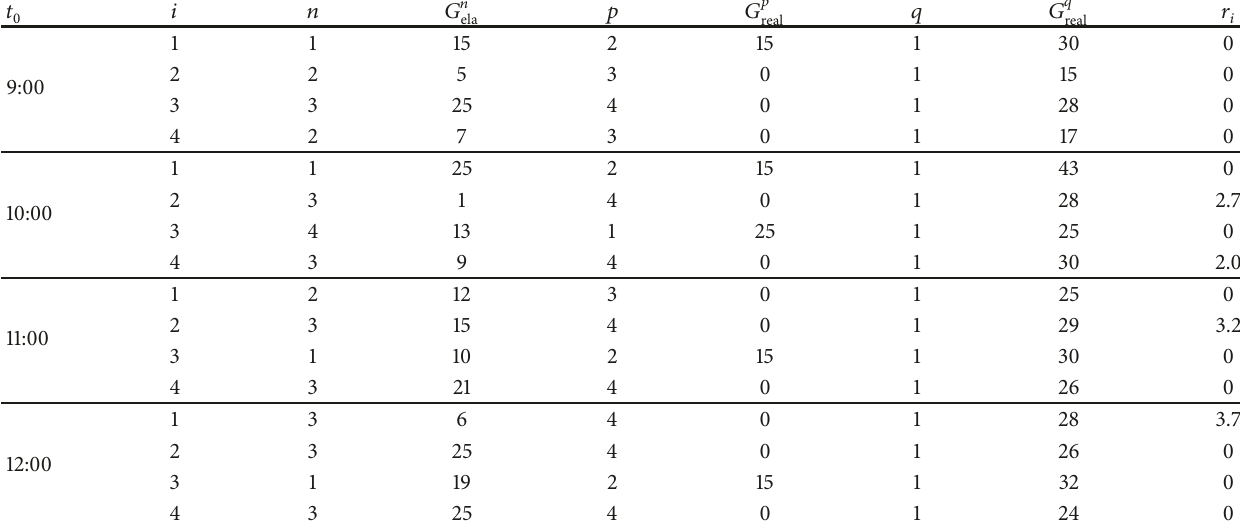
Table 1: Simulation results of EV arriving at different time.